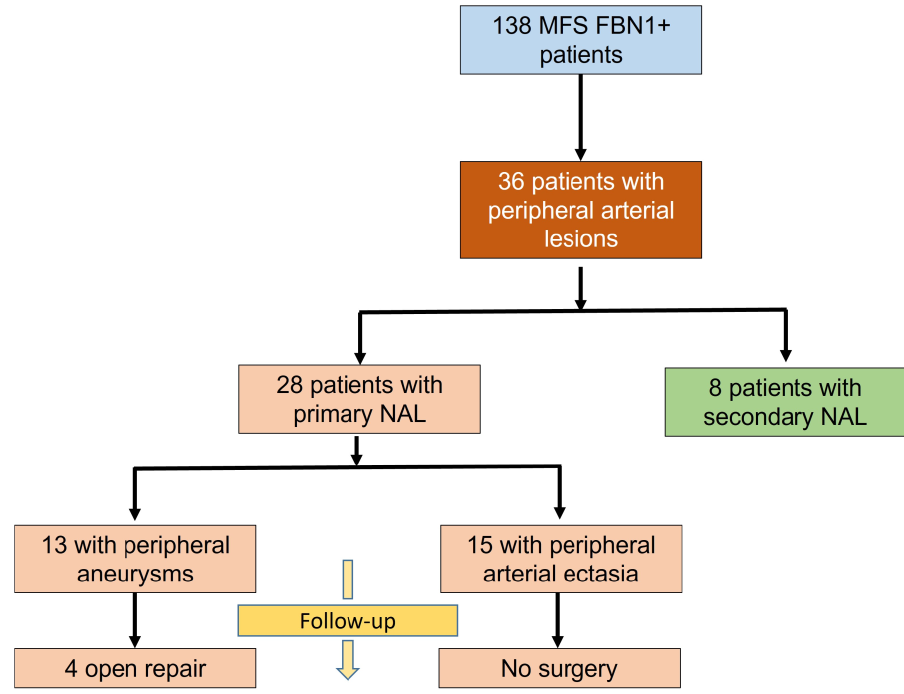
Figure 1. Study flowchart of the cohort and outcomes of patients presenting with primary non-aortic lesions (NAL).